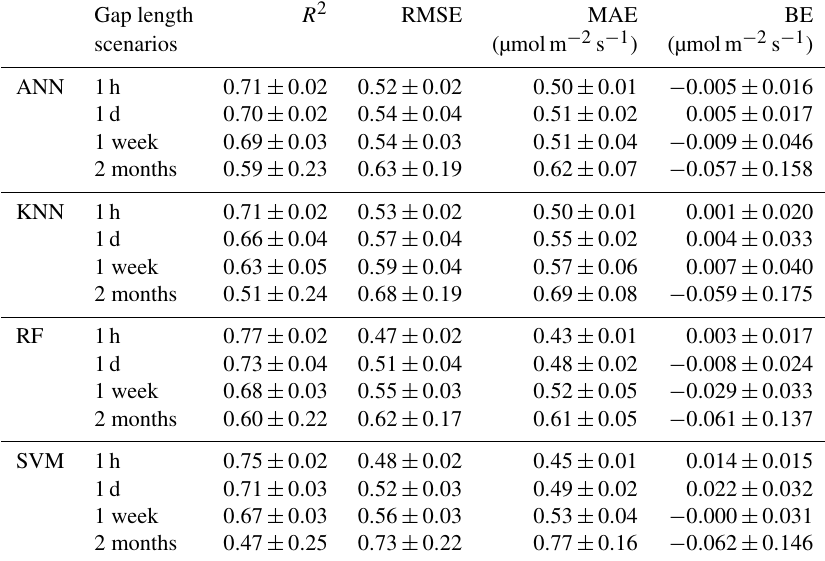
Table 2. Performance metrics of the four ML gap-filling algorithms for the four gap length scenarios. The ML algorithms are trained and evaluated without separating daytime and nighttime data.